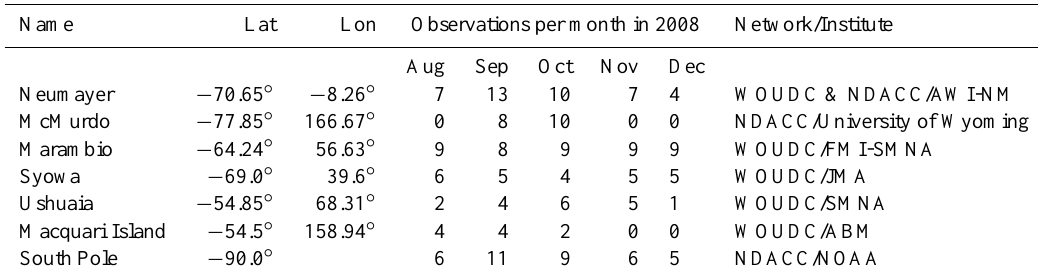
Table 3. Ozone sondes used for the evaluation.